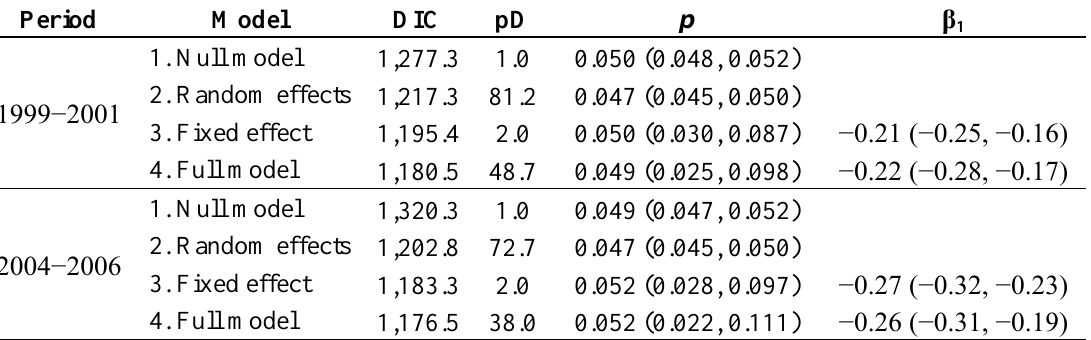
Table 2. Summary of model diagnostics: Deviance Information Criterion (DIC), effective number of parameters (pD), mean probability of poor fetal growth ( p ), and the slope parameter (β ) for the socioeconomic effect (this measures the rate of change in the log 1 odds of poor fetal growth for an increase of one standard deviation in the Advantage- Disadvantage Index). Values in brackets delimit Bayesian 95% credible